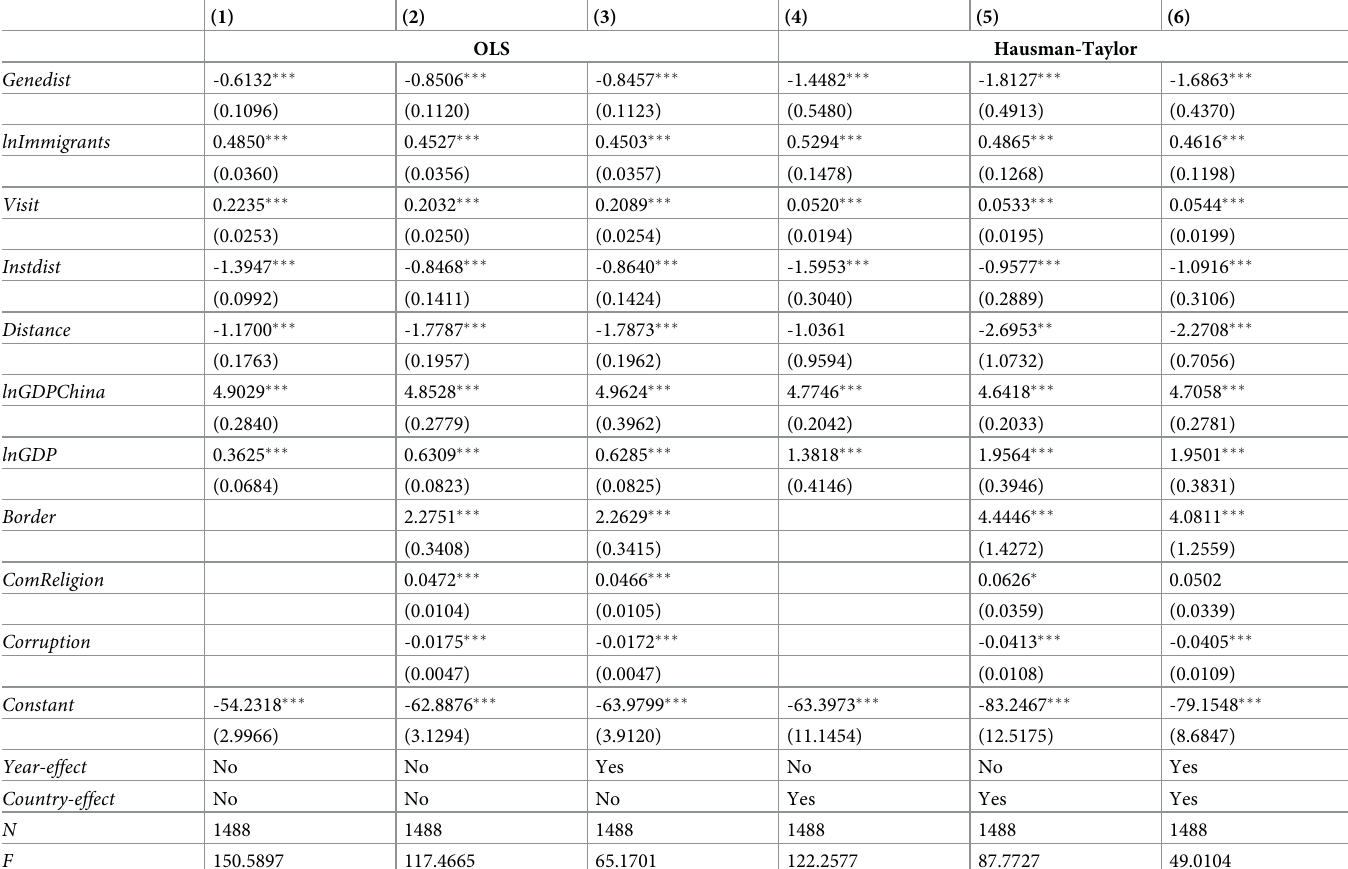
Table 3. The impact of “intimate” relations on China’s OFDI in energy sector: Baseline